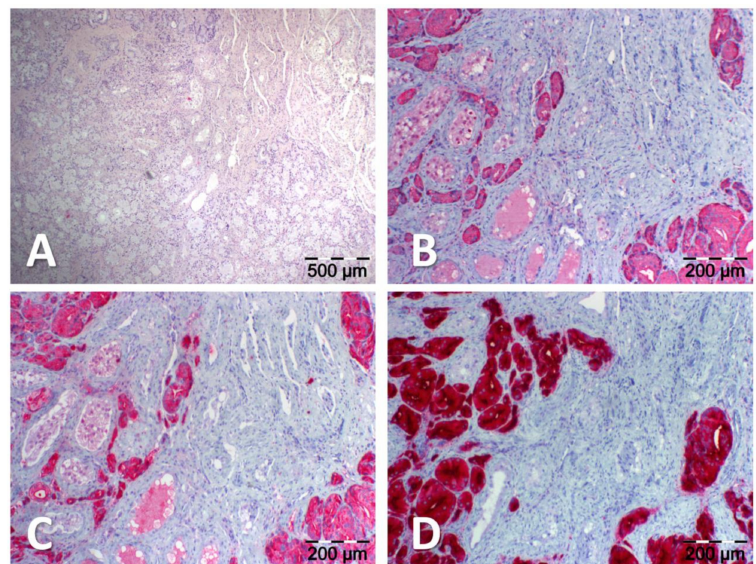
Figure 2. Histological findings. The site of tumor manifestation stained using hematoxylin and eosin (H&E). Lesional cells (red) were of prostatic origin as proven by the results of immunohistochemistry (IHC) with antibodies to the prostatic acid phosphatase (PAP; EC:3.1.3.2), the prostate-specific antigen (PSA; EC:3.4.21.77) or the prostate-specific membrane antigen (PSMA; EC:3.4.17.21). ( A ):